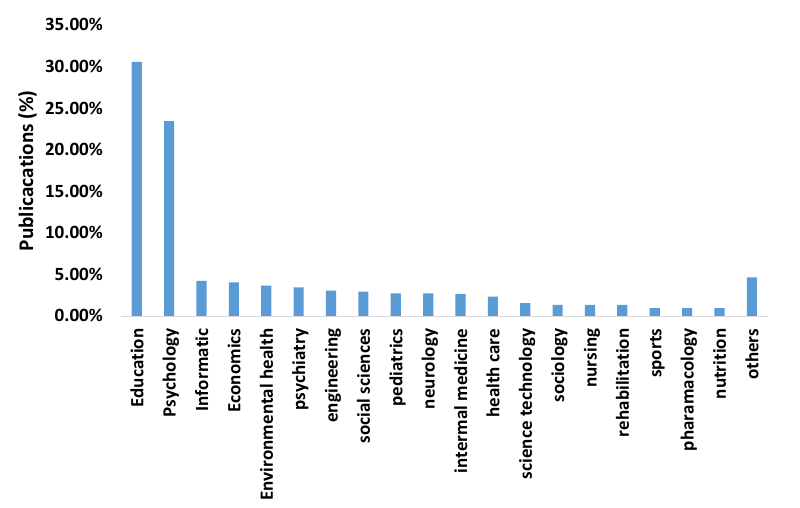
Figure 3. Percentage of publications by research field.